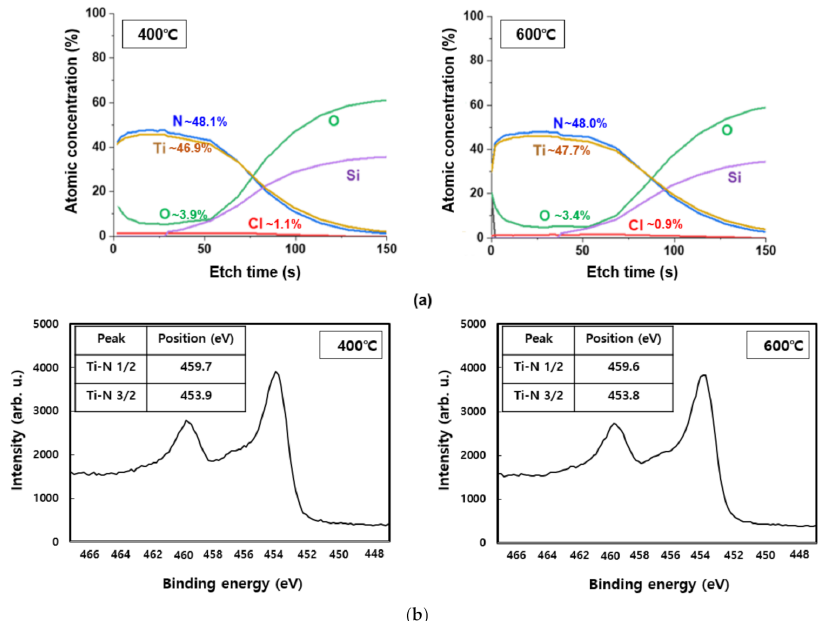
Figure 5. XPS analysis according to the deposition temperature change of TiN thin film: ( a ) depth profile, ( b )